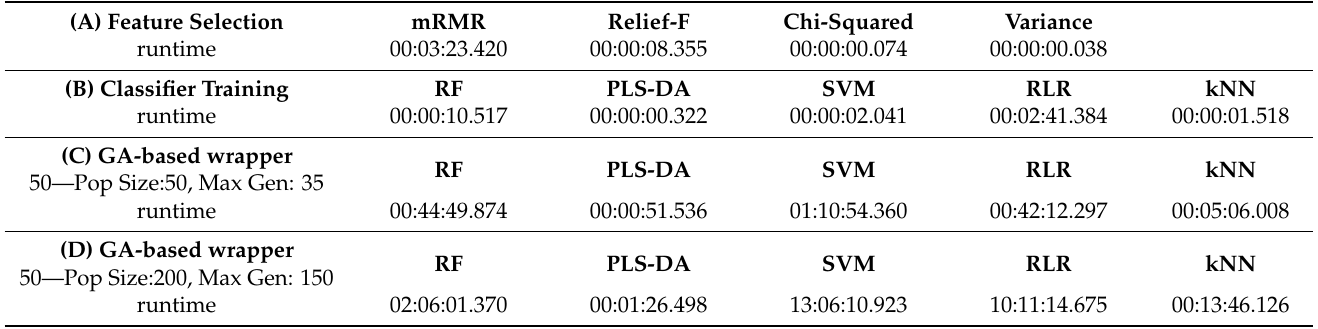
Table 3. Runtime to ( A ) rank features with each feature selector, ( B ) train classification learning algorithms on 50 features, ( C ) solving the GA-based optimization problem with 50 features, popula- tion Size = 50 and maximum number generations = 35, and ( D ) solving the GA-based optimization problem with 50 features, population size = 200 and maximum number of generations = 150. Values are reported in hours, minutes, seconds and milliseconds (HH:mm:ss.SSS).